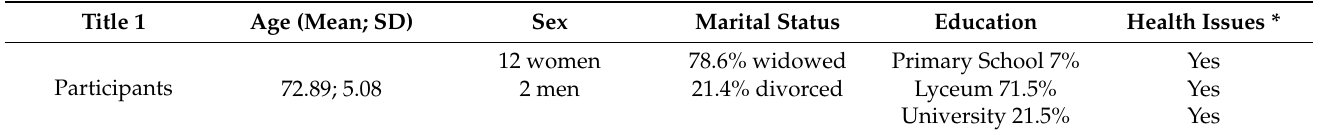
Table 1. Descriptive statistics of the participants (older people).